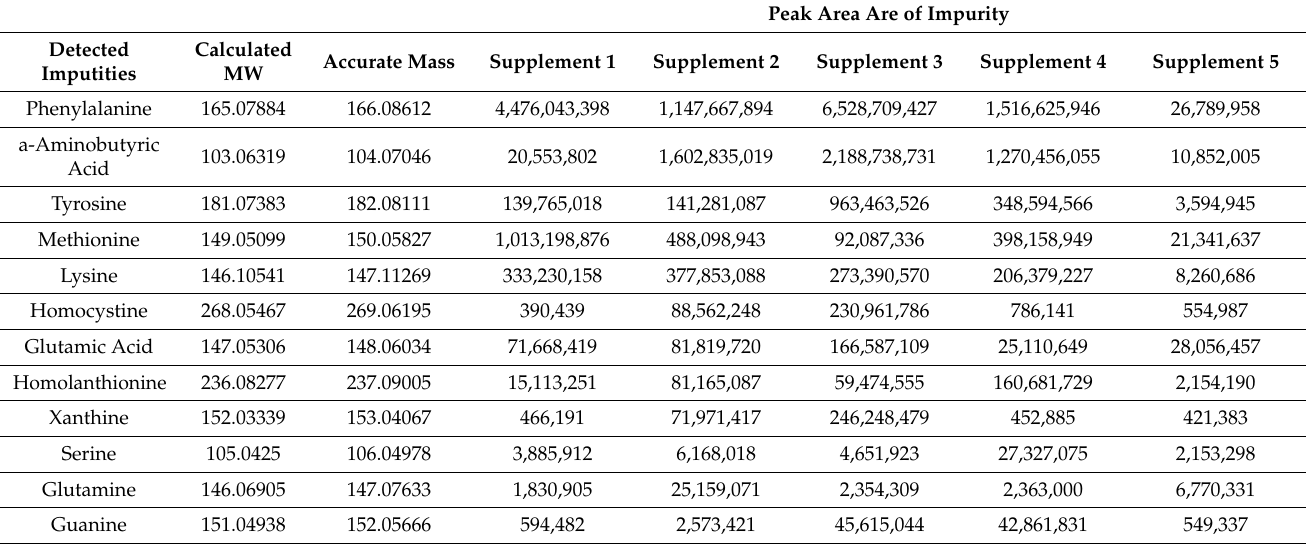
Table 3. The individual impurities and their peak area detected by LC/MS in dietary supplements containing branched-chain amino acid (BCAA). Samples were dissolved in water and prepared at final concentrations equal to 1